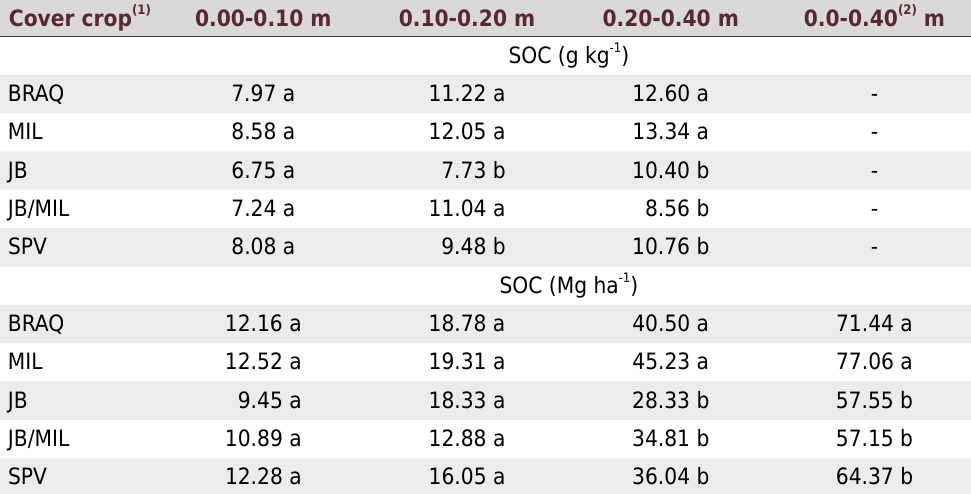
Table 2. Soil organic carbon (SOC) contents and stocks in the 0.00-0.10, 0.10-0.20 and 0.20-0.40 m layers in an orange orchard with different cover